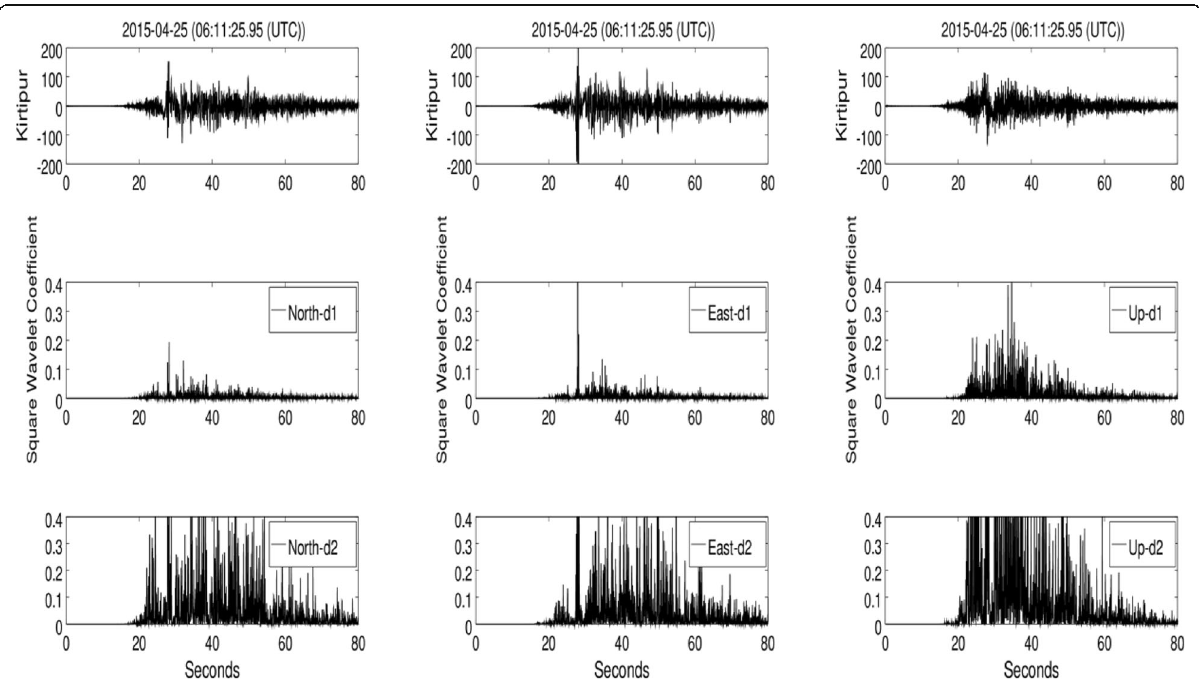
Fig. 14 Square wavelet coefficient dj (j = 1 and 2) of ground motion in NS, EW and Vertical direction observer at KTP